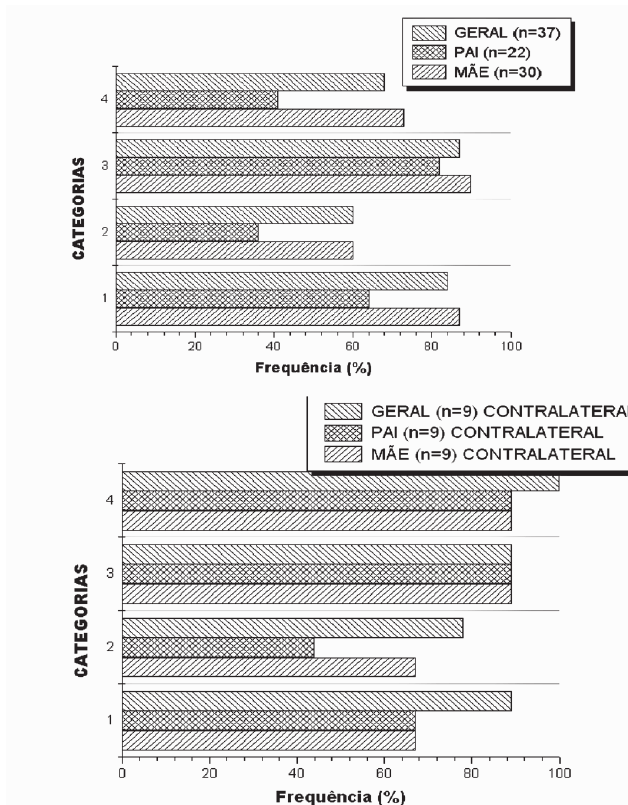
Figura 3. Porcentagens de ocorrência do fenômeno de muitas-faces com fotos do pai e da mãe nas condições no ponto cego e contralateral ao ponto cego. A categoria “Geral” reúne as condições mãe e